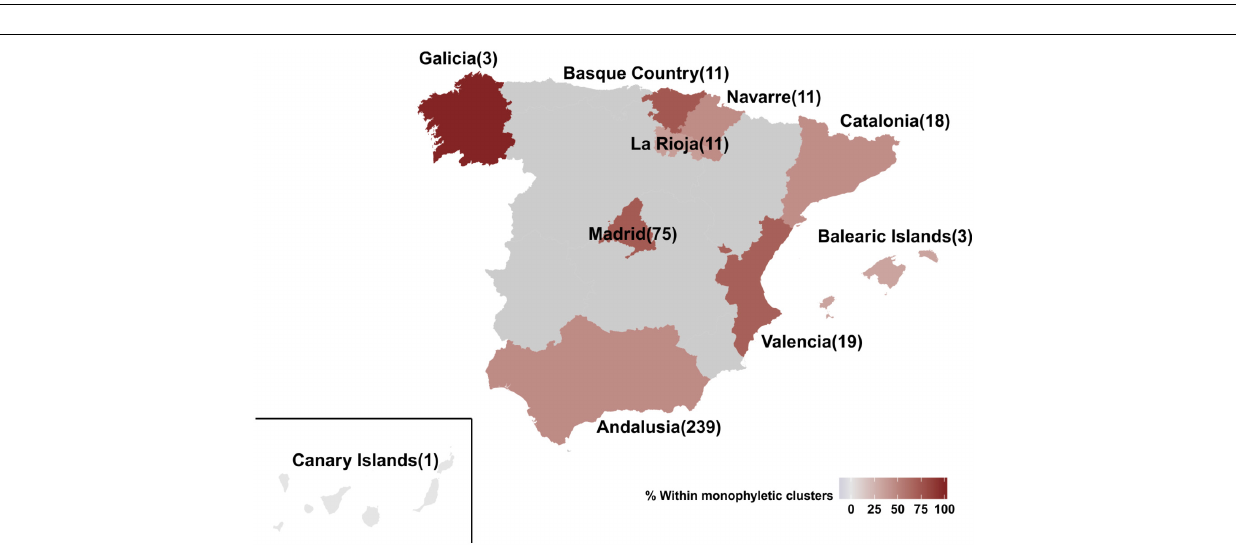
FIGURE 1 | Unrooted phylogenetic trees estimated by RAxML v8.0.20 of HIV-1 CRF02_AG sequences sampled from Spain and a global reference dataset. (A) Sequences from Spain are marked in red in contrast with sequences from other areas marked in light blue. (B) Sequences from Spain are marked in red in contrast with sequences from other countries (Cameroon, Senegal, Niger, Ghana, Mali, the United States, Burkina Faso, Togo, Italy, Russia, Benin, Gabon, Germany, Belgium, the United Kingdom, Japan, France, Mauritania, Portugal, Sweden, Equatorial Guinea, the Czech Republic, Denmark, Cyprus, Australia, and Canada) and geographical areas (Western Europe, Sub-Saharan Africa, Central Asia, East Asia, Central and Eastern Europe, Southeast Asia, and Latin America) marked in different colors. Monophyletic clusters according to geographic region of sampling are indicated as triangles.